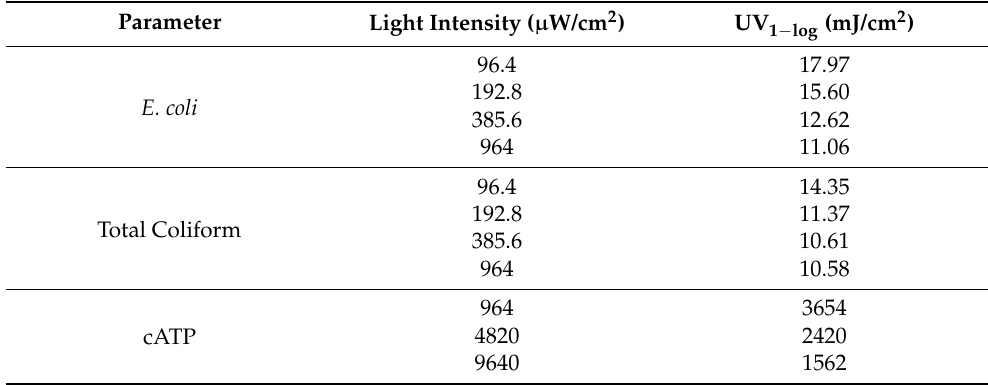
Table 3. Summary of the UV dose required for one log reduction of different